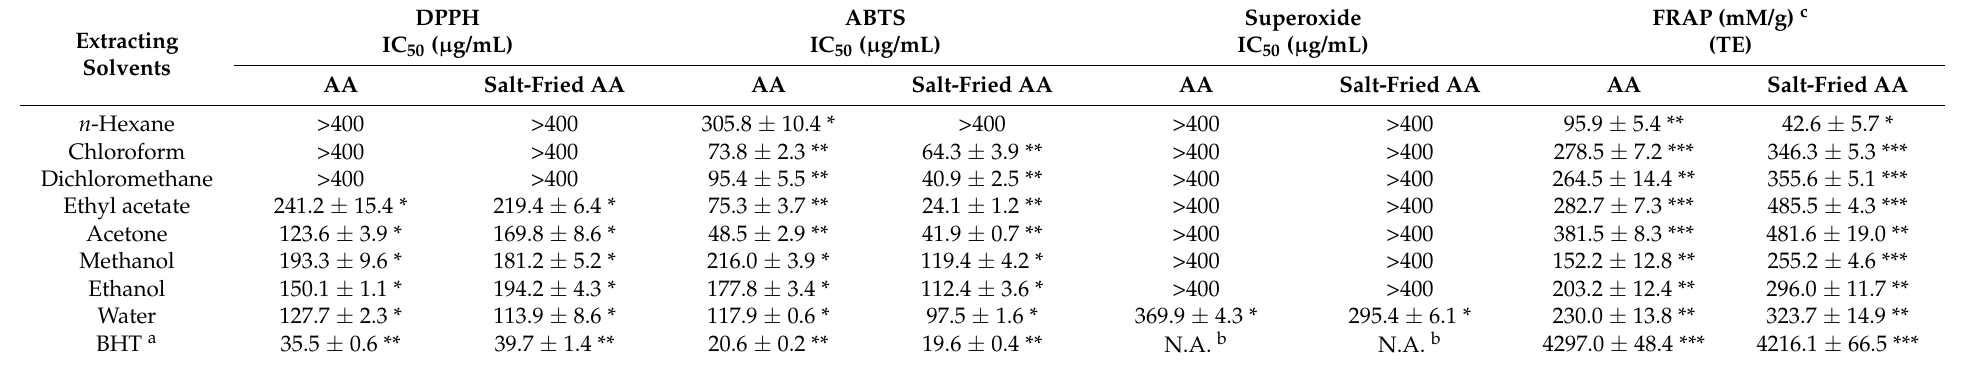
Table 2. The antioxidant activities of different solvent extracts from Anemarrhena asphodeloides determined with DPPH, ABTS, superoxide radical scavenging, and ferric-reducing antioxidant power (FRAP)